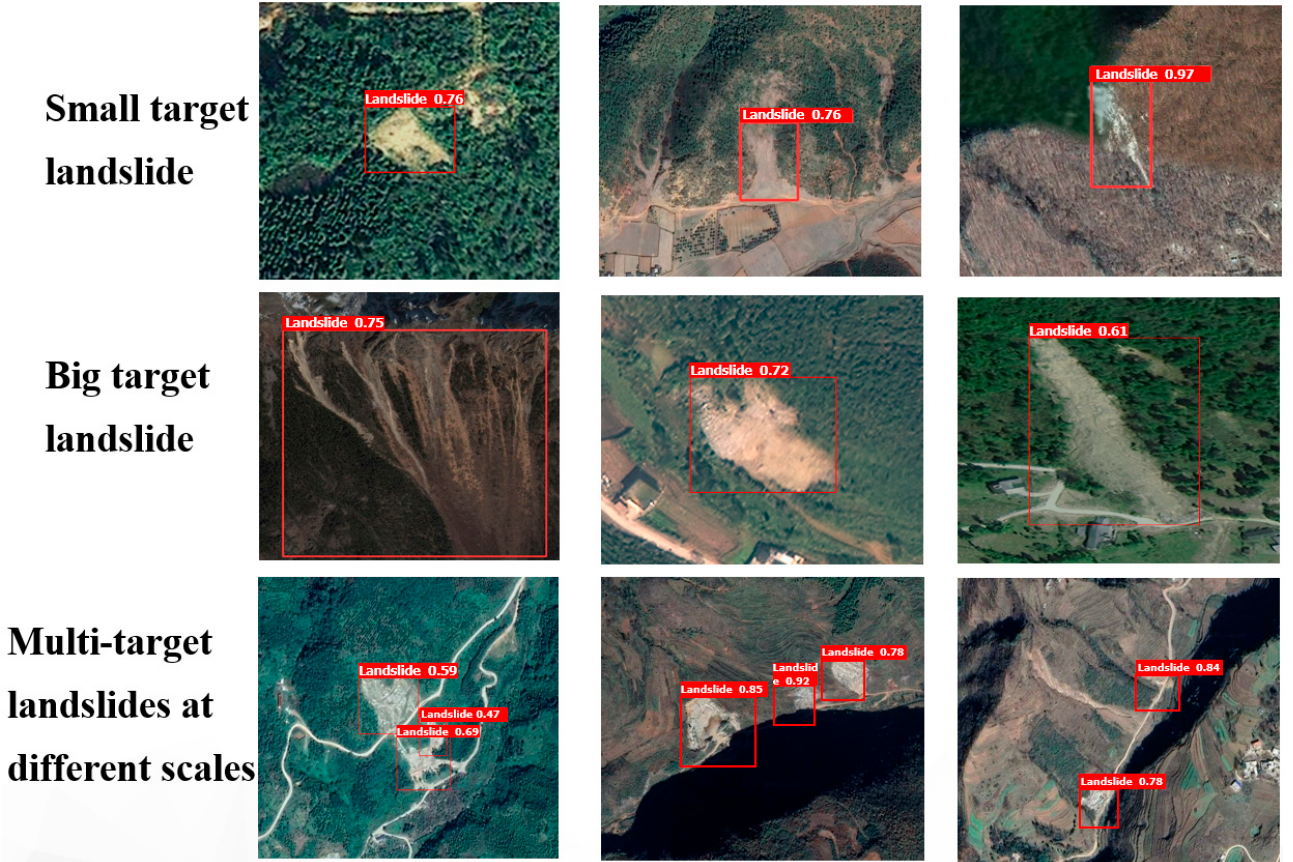
Figure 16. Part of the detection results of landslide detection using our model.